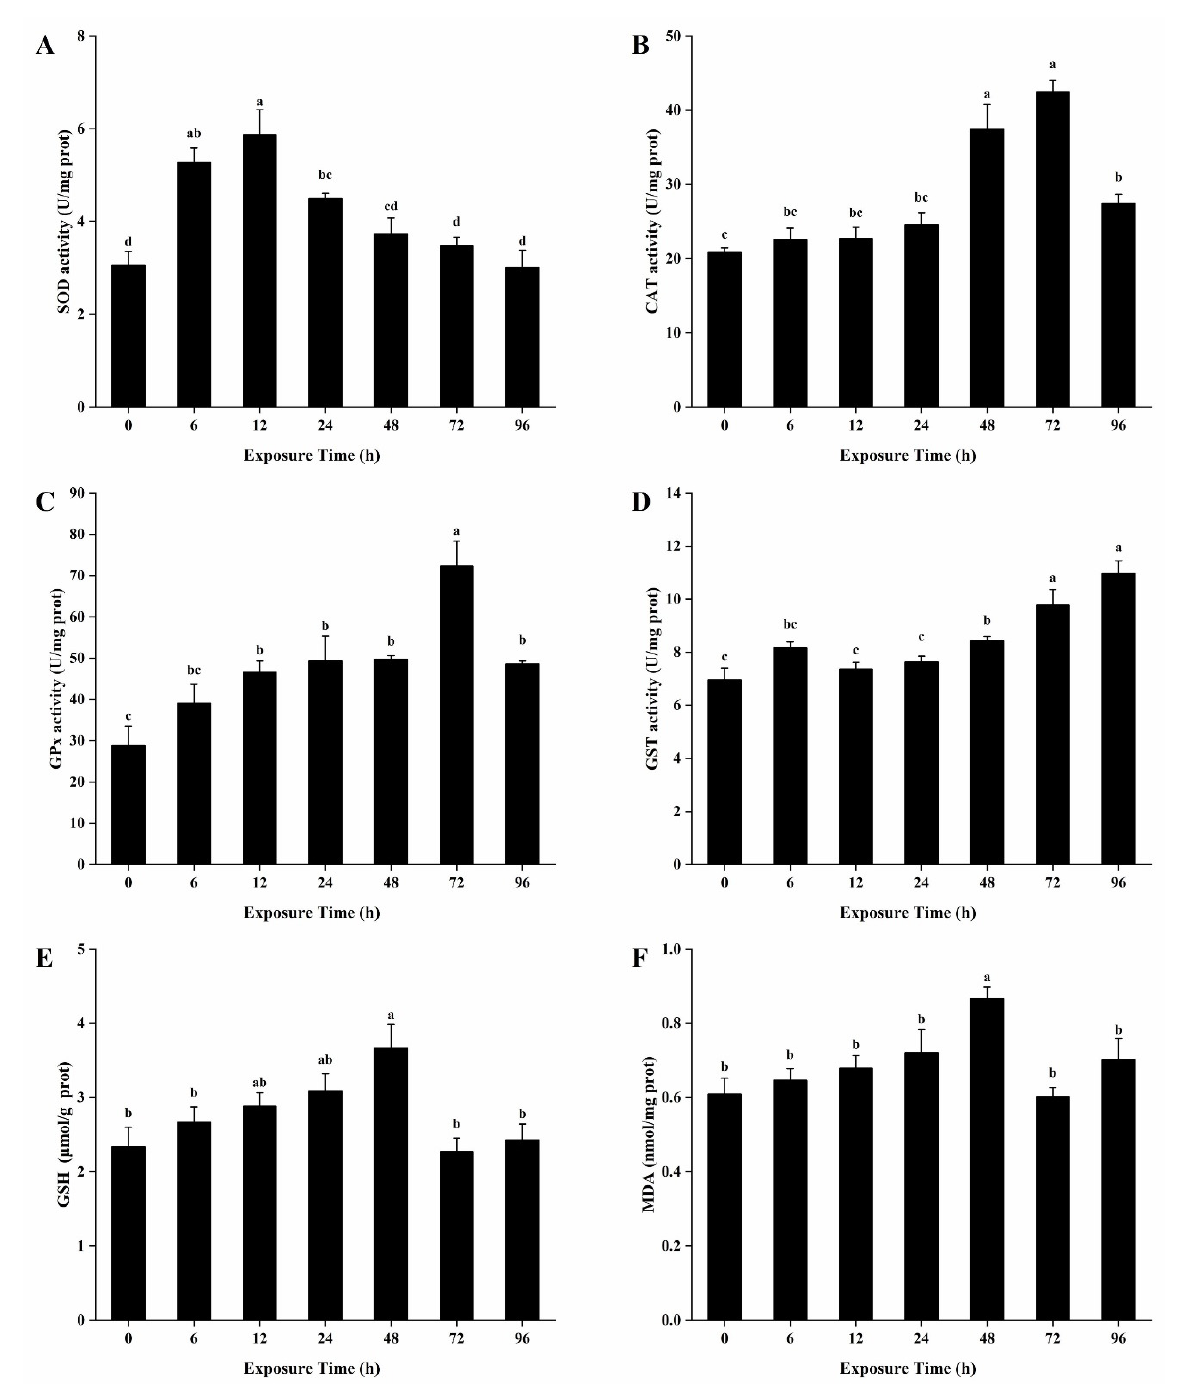
Figure 2. The activities of SOD ( A ), CAT ( B ), GPx ( C ), and GST ( D ) and the contents of GSH ( E ), MDA ( F ) in the hepatopancreas of H. cumingii exposed to 6.43 mg L − 1 unionized ammonium for 0 (control), 6, 12, 24, 48, 72, and 96 h. Values are presented as the mean ± SE (n = 6). Superscripted lowercase letters indicate a significant effect of exposure time ( p < 0.05).